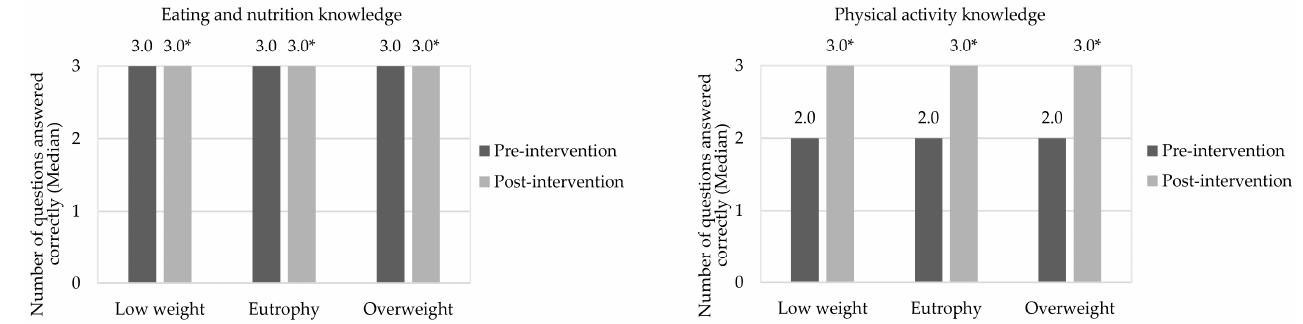
Figure 5. Correct answers to questions about knowledge of eating, nutrition, and physical activity in the pre- and post-intervention stages, considering the children’s nutritional statuses. * Indicates significant difference by Wilcoxon Test ( p -value < 0.05), in relation for correct answers to questions of the questionnaires about knowledge in eating, nutrition, and physical activity in the pre- and post-intervention stages. The assessment was performed between the same nutritional status. Grade scale: 1—low, 2—good, and